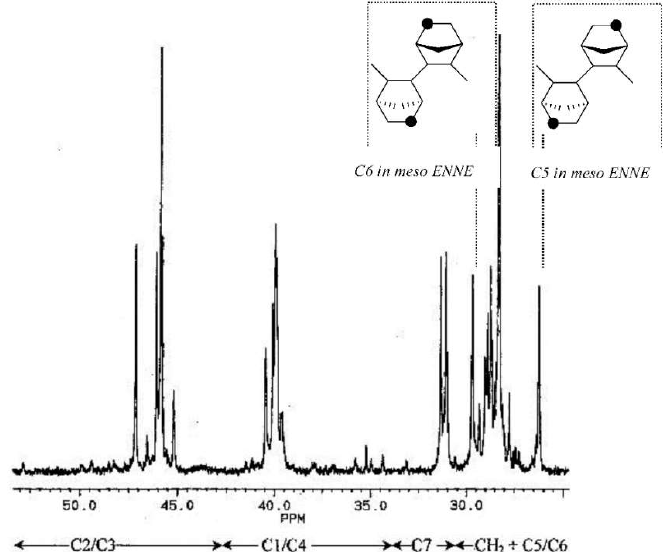
Figure 4. 13 C NMR spectrum of a poly(E- co -N) with 50.8 mol % of N produced by rac -Et(Indenyl) 2 ZrCl 2 ( 1 ) [34].